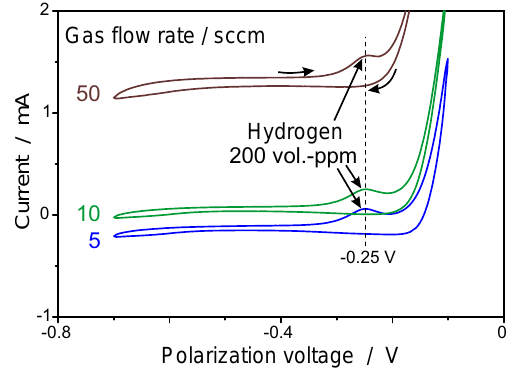
Figure 11. Voltammograms for measuring gases with 200vol.ppm H 2 – each at different gas flow rates; cell temperature: 700 ◦ C; po- tential scan rate: 10mVs − 1 ; electrode size: 7.5cm 2 ; open-circuit potential: − 161mV (5sccm) to − 1030mV (50sccm); the second cycle is shown.